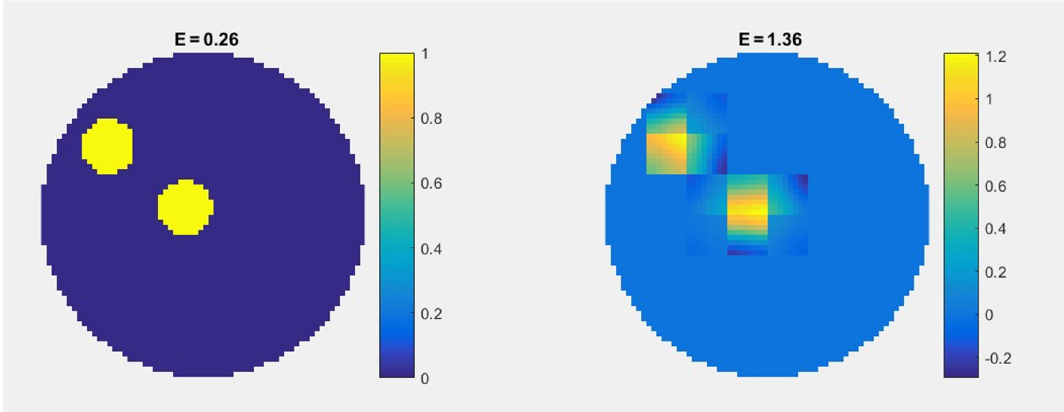
Figure 11. Direct decompression.